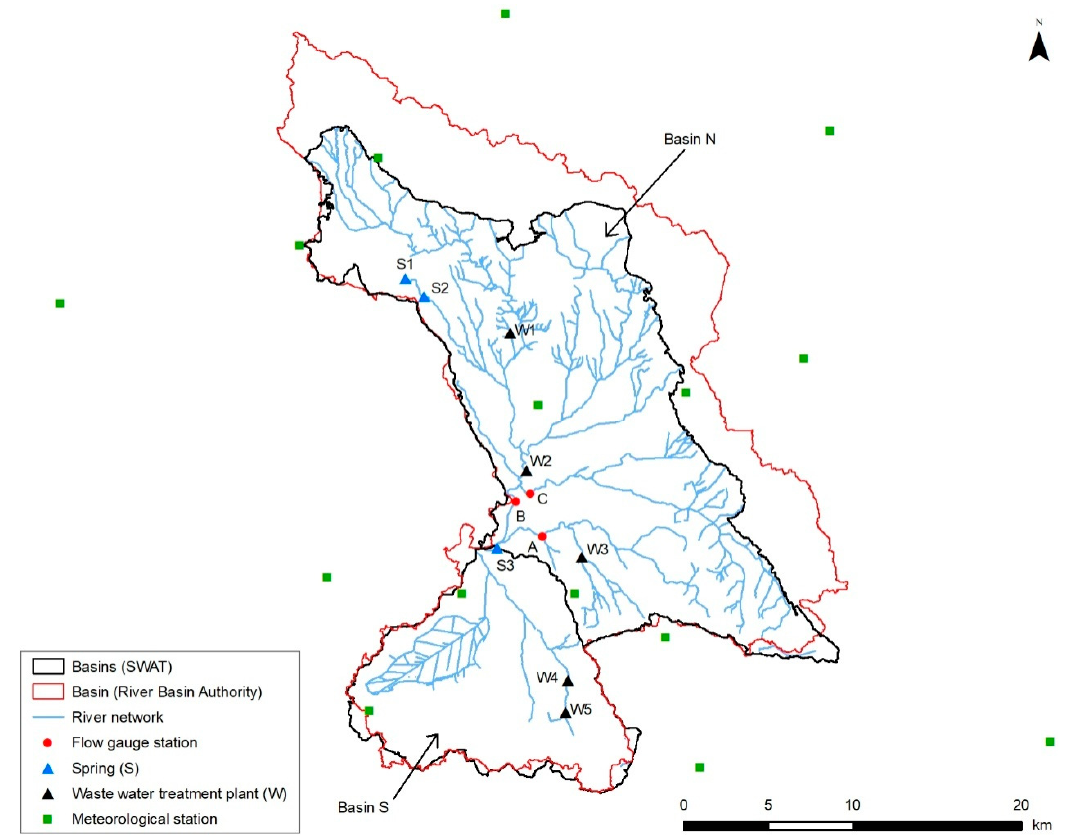
Figure 8. Initial basin (River Basin Authority), basins (Basin N, Basin S) contributing to surface runoff, point sources (springs and wastewater treatment plants), flow gauging stations, and weather stations.